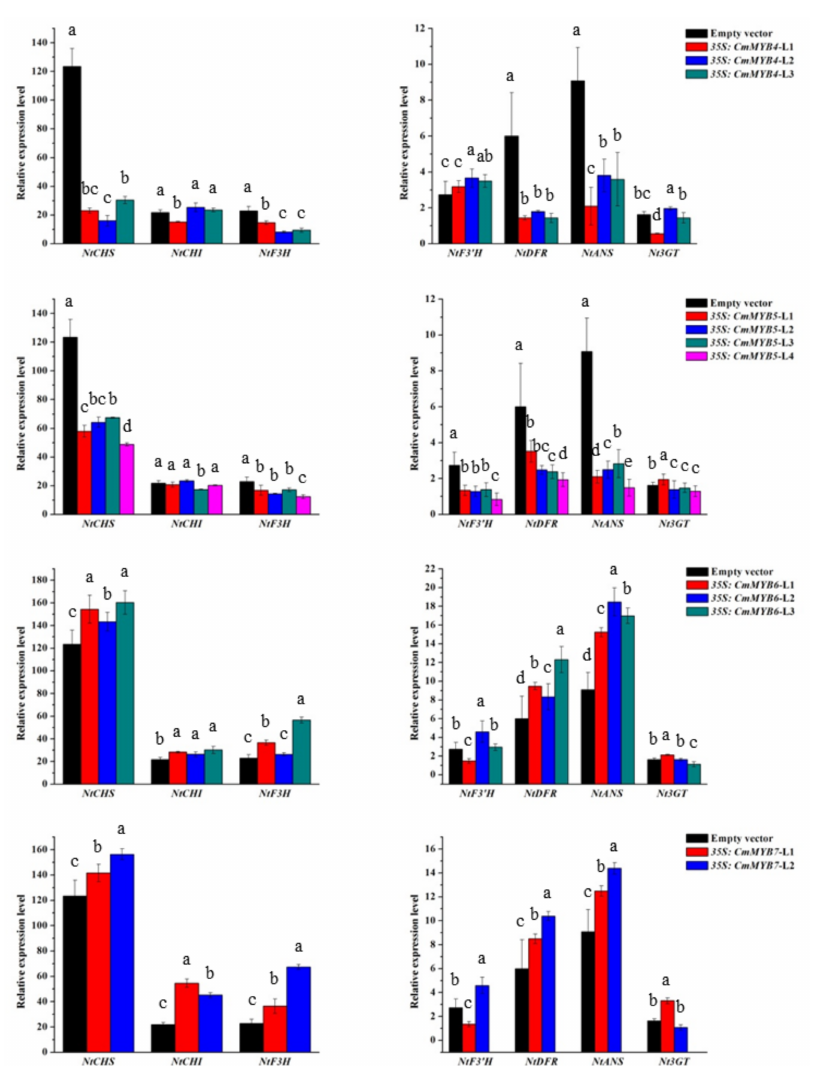
Figure 4. The relative expression levels of seven anthocyanin biosynthetic genes in the 35S: CmMYBs tobacco lines. The results are presented as the mean ± SD of three replicates. Di ff erent letters represent significant di ff erences at p < 0.05 between di ff erent samples. L1, L2, L3, and L4 indicate independent transgenic tobacco lines obtained in the present